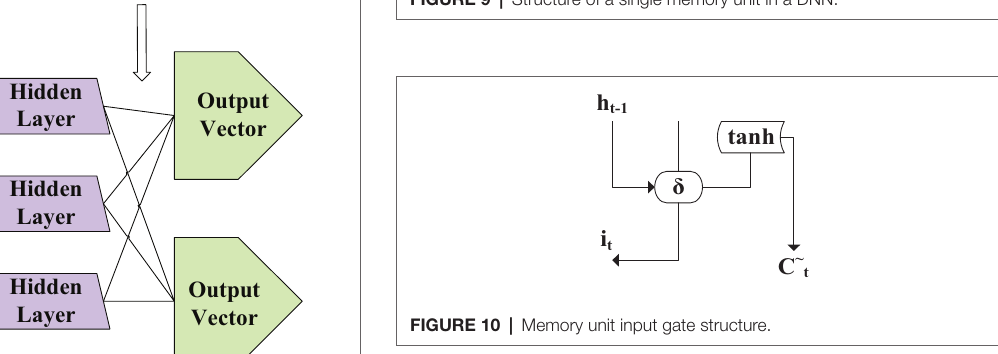
FIGURE 9 | Structure of a single memory unit in a DNN.